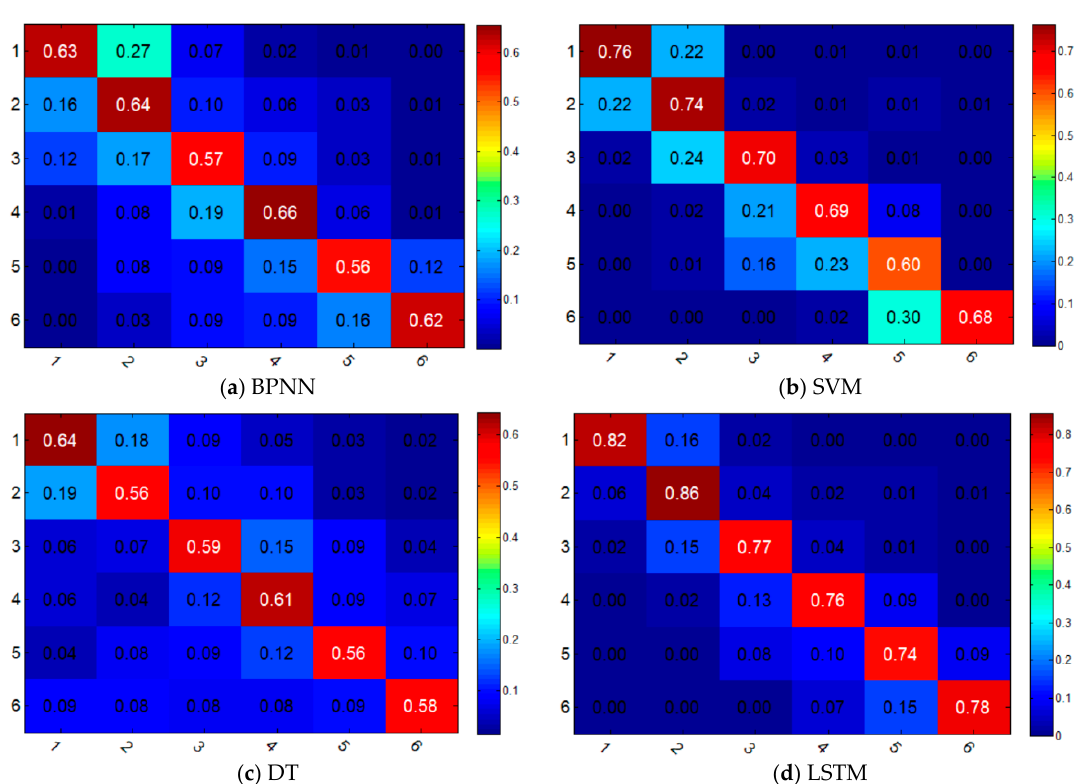
Figure 7. Multi-class confusion matrix of the four models for landslide hazard prediction.